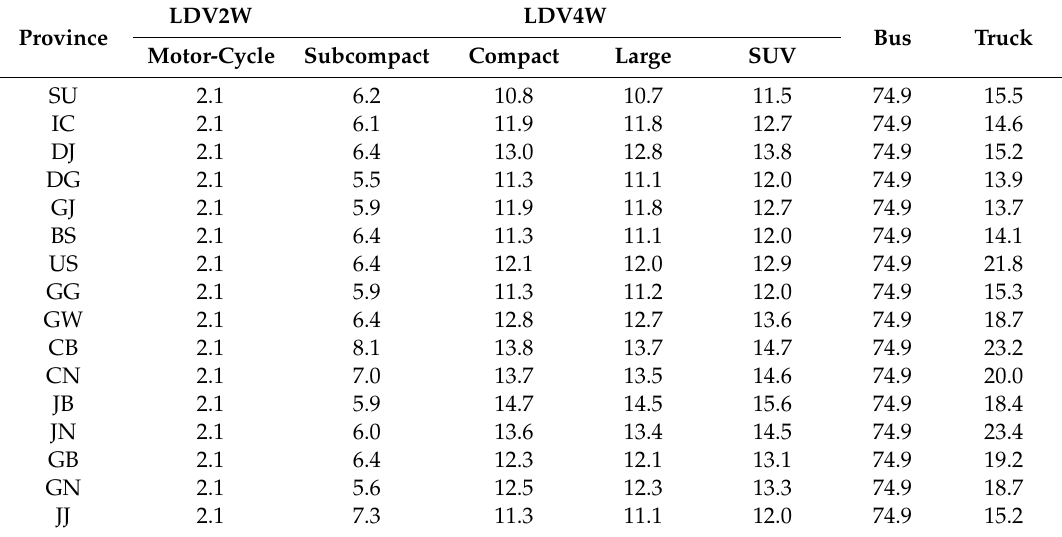
Table A2. Average Subsidy for Battery Electric Vehicles by Province in 2020 (Unit: